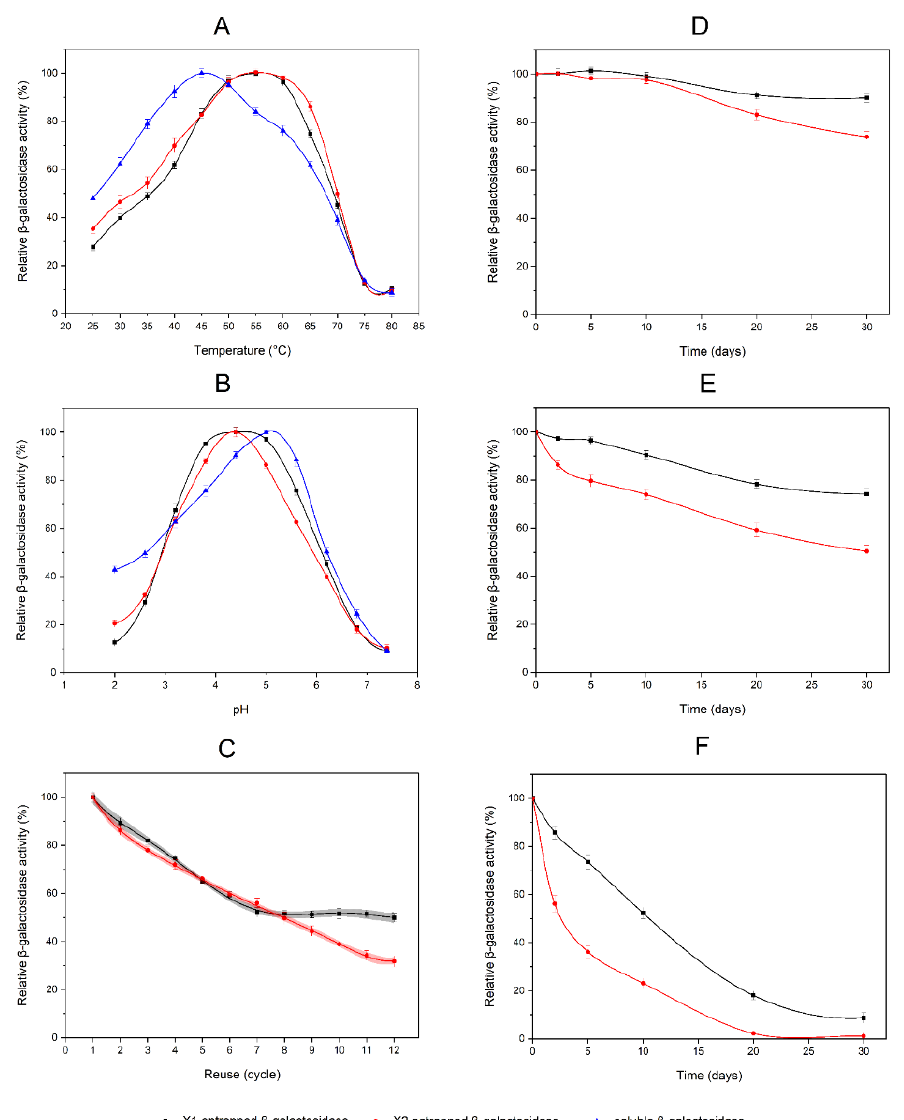
Figure 6. Properties of entrapped β -galactosidase in PDMS-modified and non-modified silica com- posites: ( A ) temperature profiles; ( B ) pH profiles; ( C ) reusability of entrapped β -galactosidase—the 95% confidence bands are marked in gray and light red; ( D ) β -galactosidase stability tests at 4 ◦ C; ( E ) β -galactosidase stability tests at 25 ◦ C; ( F ) β -galactosidase stability tests at 40 ◦ C. The data shown are the means of three independent experiments ± standard deviations. Black squares ( — (cid:4) — ) repre- sent data for β -galactosidase entrapped in the PDMS-modified composite—X1; red circles ( — • — ) represent data for β -galactosidase entrapped in the non-modified composite—X2; blue triangles ( — (cid:78) — ) represent data for free soluble β -galactosidase. PDMS-modified composites (X1) containing β -galactosidase and silica composites (X2) with entrapped β -galactosidase were used for 12 consecutive batches of